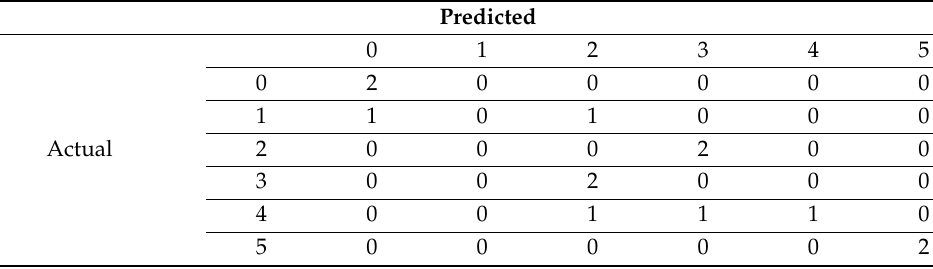
Table 8. Cubic SVM; Accuracy 38.5%.